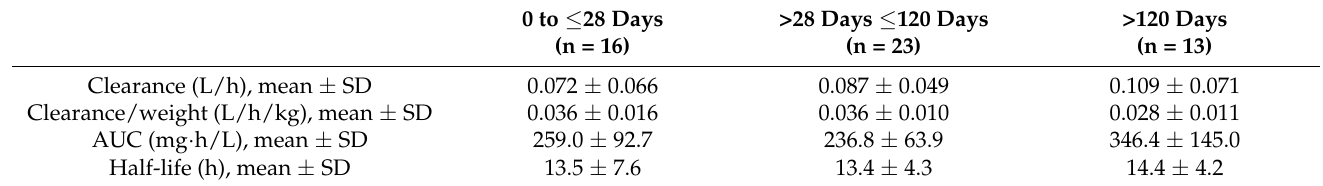
Table 2. Micafungin plasma PK characteristics in neonates and young infants up to 6 months of age.